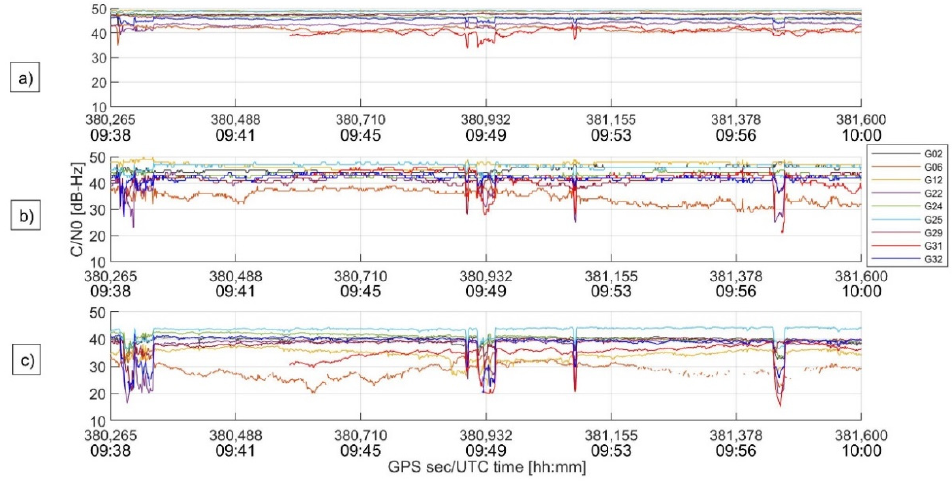
Figure 6. C/N 0 behavior for each visible satellite.